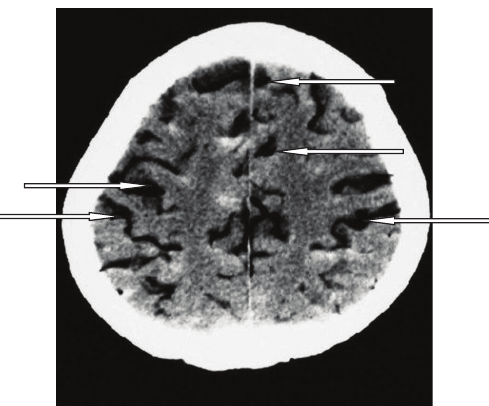
Figure 2: A section of cranial CT scan in the 8th day of admittance. Arrows show arterial air